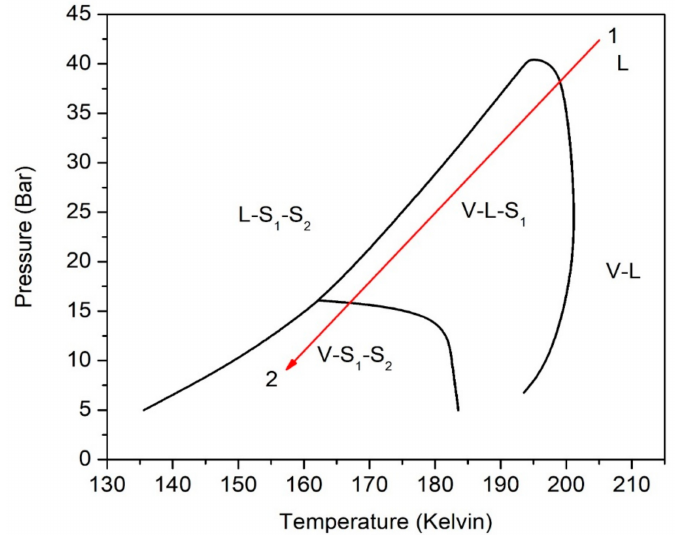
Figure 2. A simplified path for the throttling/equilibrium process (red line) versus the SLVE phase diagram [22]. Phases: V: vapor, L: liquid, S 1 : solid CO 2 , S 2 : solid H 2